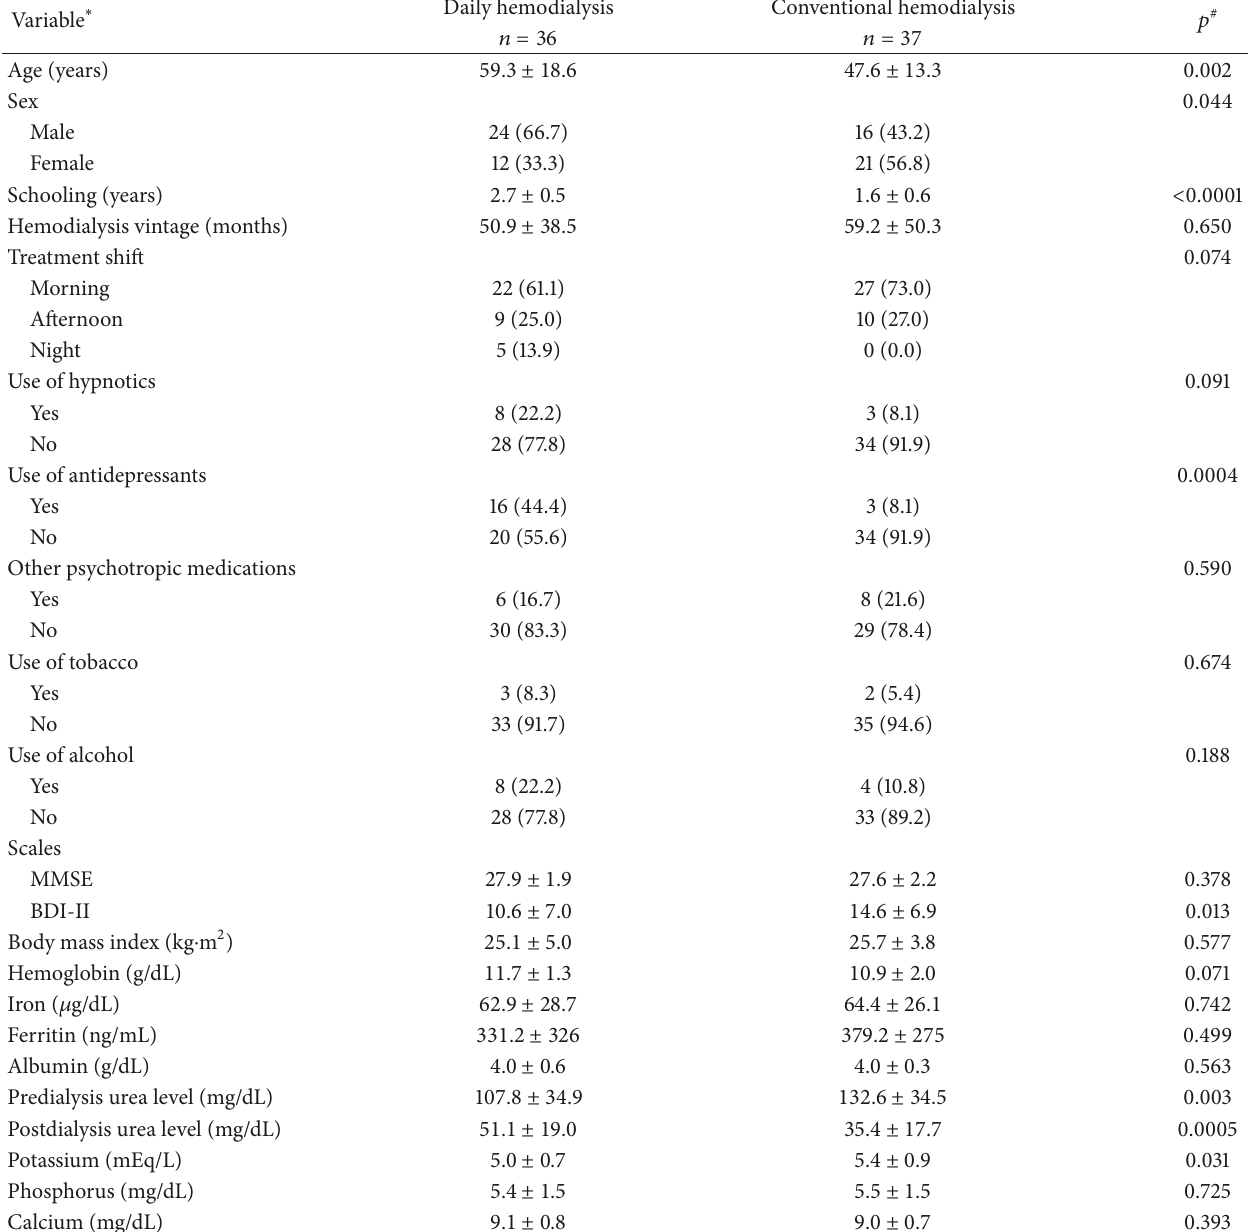
Table 1: Demographic and clinical variables of patients undergoing dialysis (𝑛 = 73